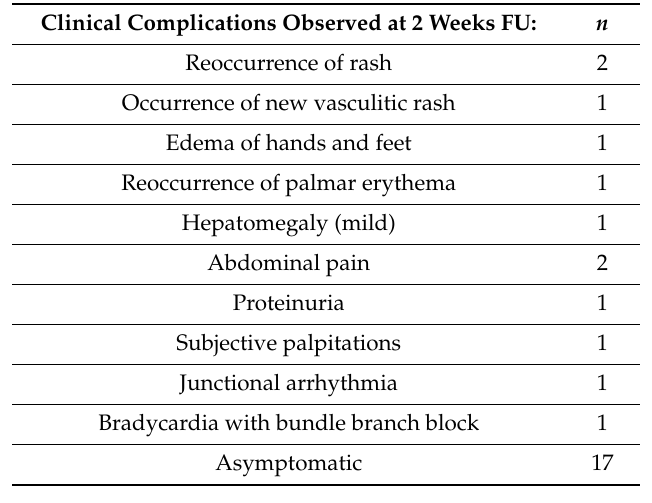
Table 4. Clinical features observed in patients with paediatric inflammatory multisystem syndrome temporally associated with SARS-CoV-2 at follow-up 1–2 weeks after discharge. Three children presented with arrhythmias that were identified as a new finding following their